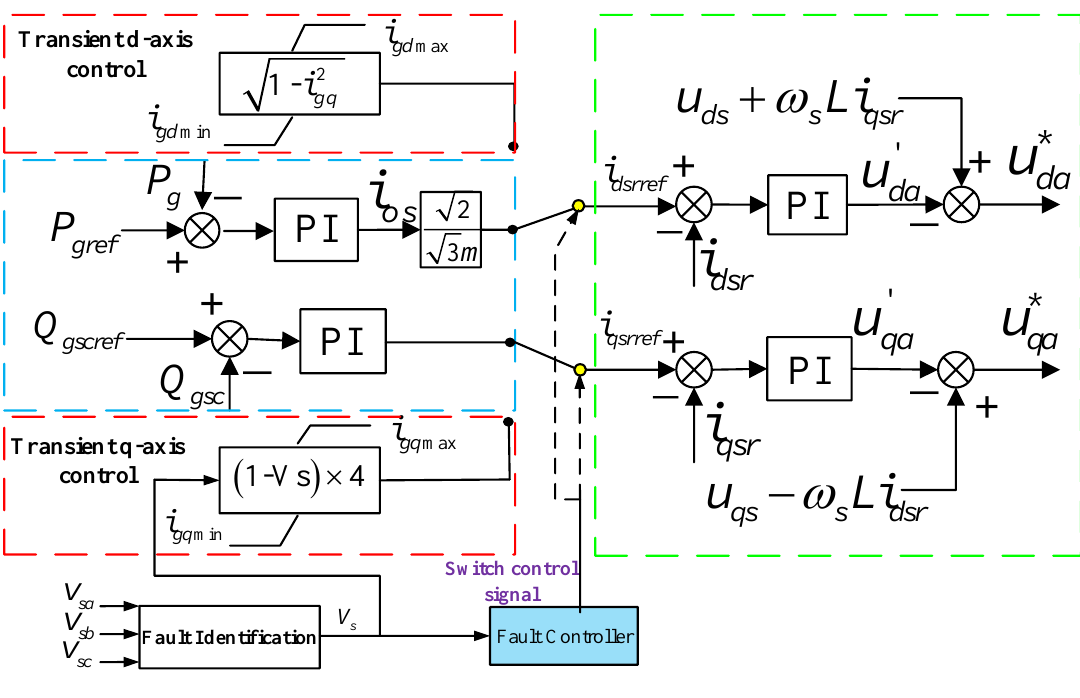
Figure 6. Controllers of grid-side converter